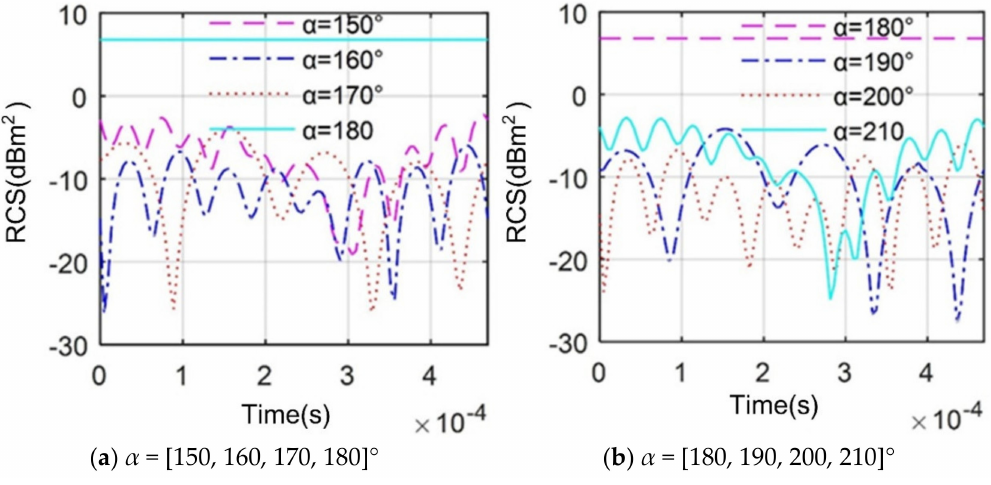
Figure 11. Influence of azimuth on dynamic RCS of m low , N obs,low = 1, α = 150 ◦ ~210 ◦ , and β = 0 ◦